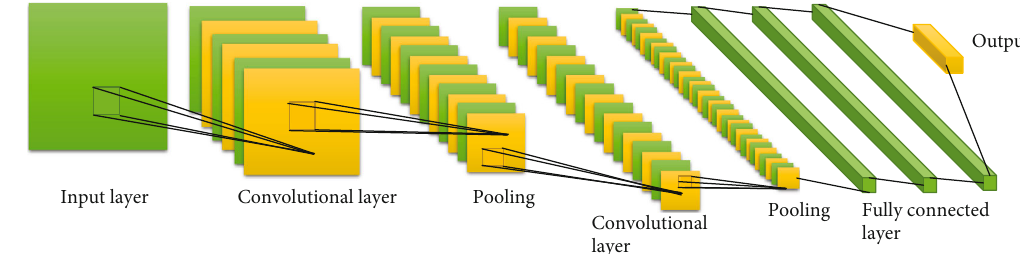
Figure 2: Diagram of the designed network structure of CNN.